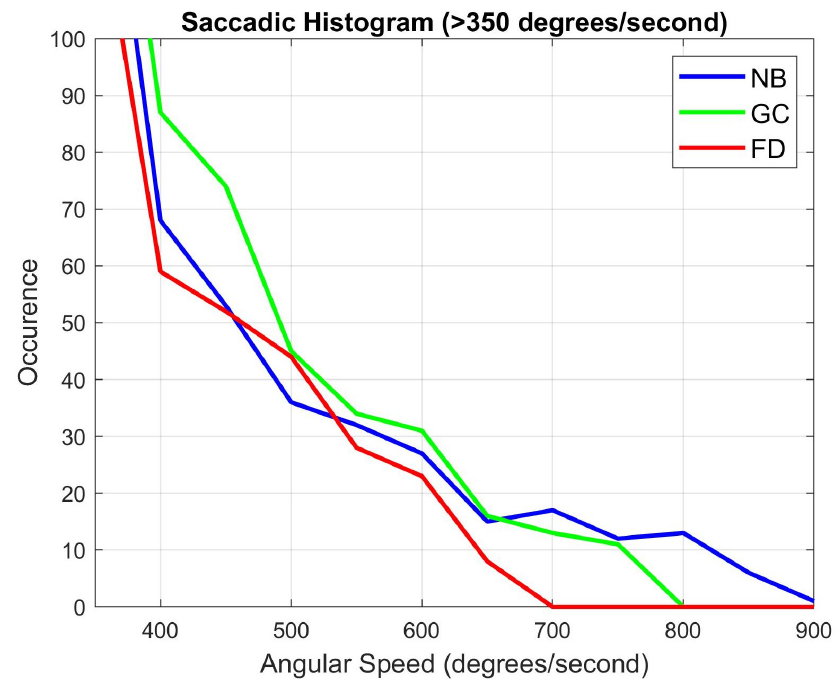
Figure 16. Histogram for angular speed greater than 350°/s of the eye for all users during a